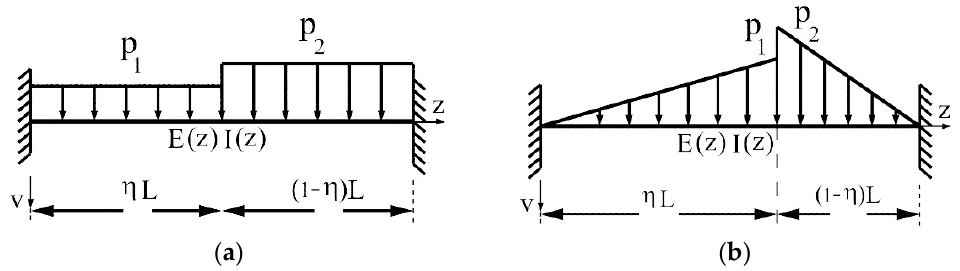
Figure 7. ( a ) Uniform beam with a constant cross section subjected to the two di ff erent uniform loads; ( b ) uniform beam with a constant cross section subjected to the two di ff erent triangular loads. η= and For 2